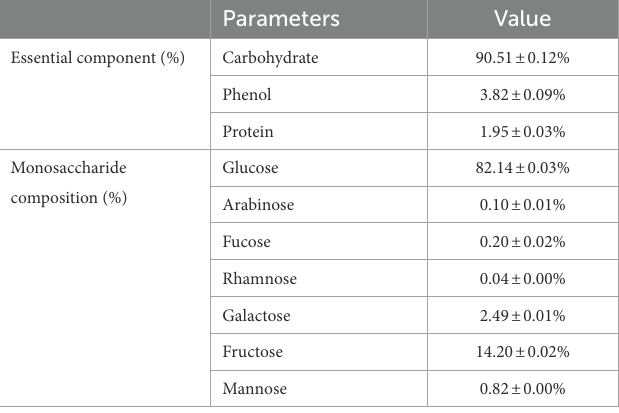
TABLE 1 Basic physical and chemical properties of LDSPs. Parameters